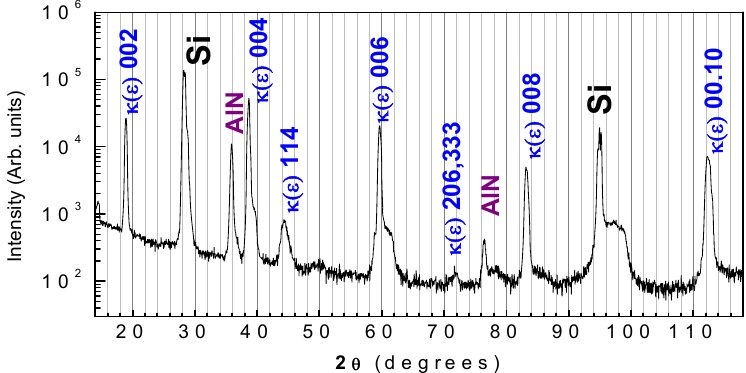
Figure 1. θ‐ 2 θ scan of the Ga 2 O 3 /AlN(0001)/Si(111) sample. Figure 1. θ -2 θ scan of the Ga 2 O 3 /AlN(0001)/Si(111)